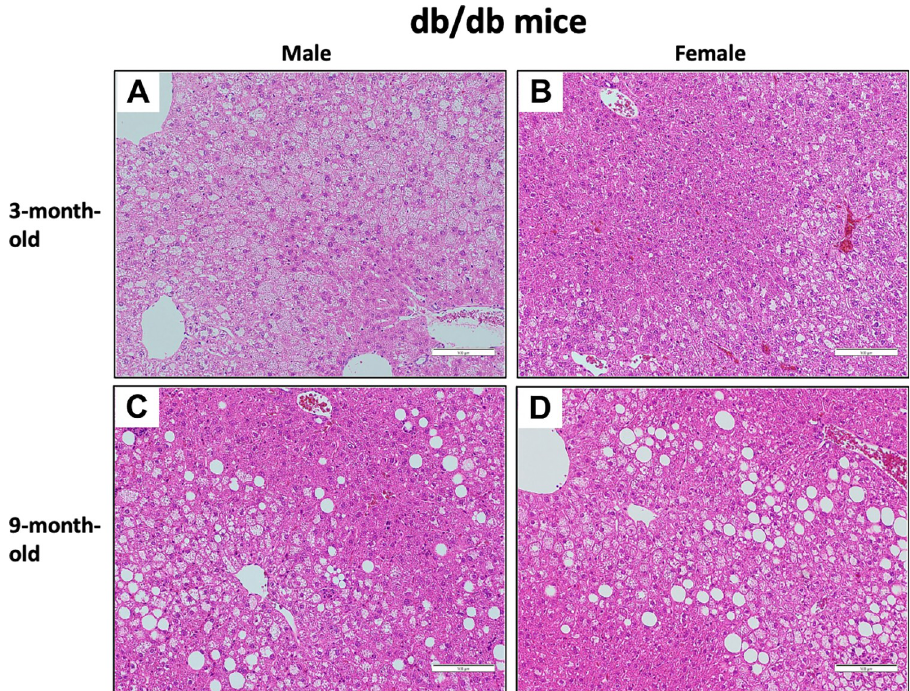
Fig 2. Photomicrographs of the liver of db/db mice at 3 and 9 months. A-D) In db/db mice, steatosis is conspicuous in both 3- and 9-month-old mice. Intralobular and portal inflammation is milder compared to that in TSOD mice, and ballooning is not conspicuous at both ages. Steatosis is more severe in male mice than females at 3 months. (H&E staining, original magnification × 200).